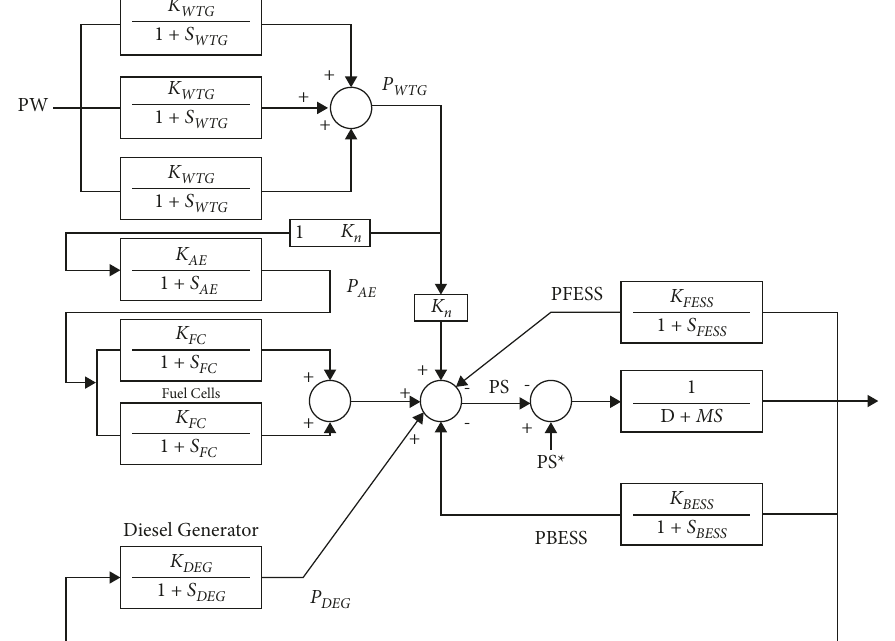
Figure 8: Block diagram of a microgrid